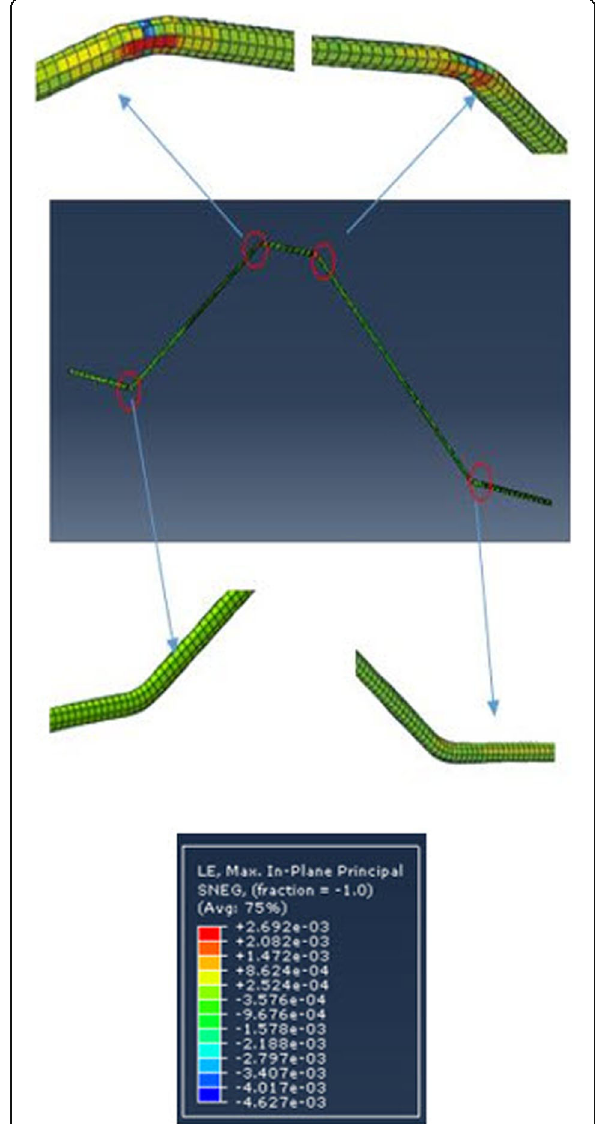
Fig. 16 Maximum axial strain at elbow at crest of slope is higher than at the toe for Northridge input motion and rock type R1 at SF =